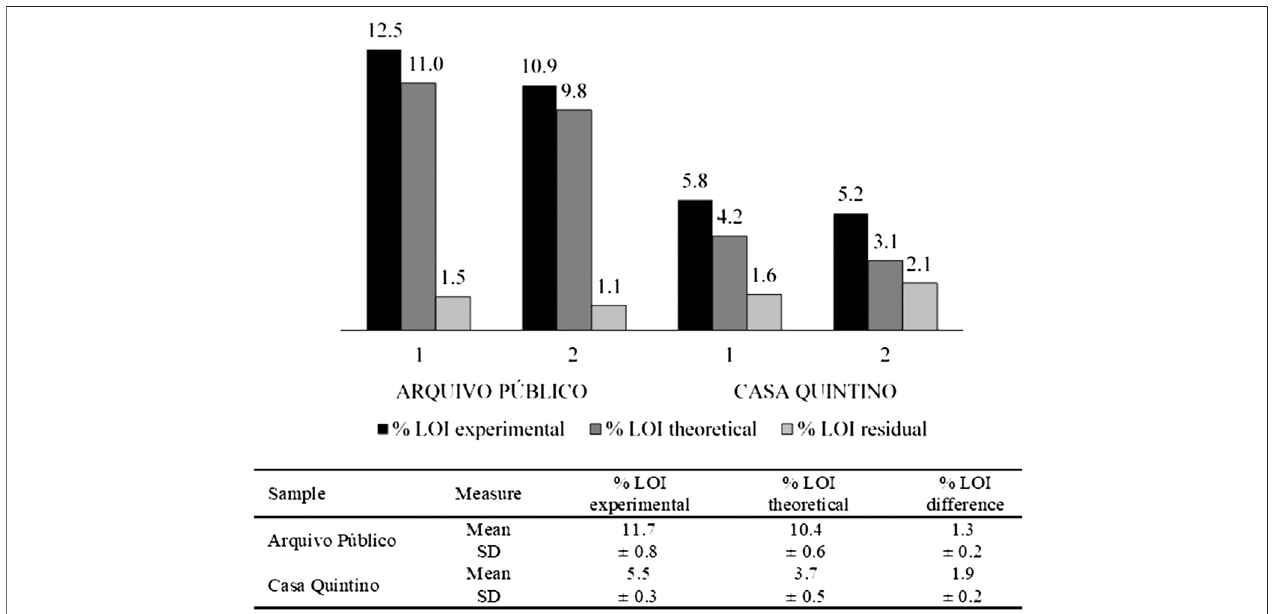
FIGURE 7 | Difference between experimental and theoretical loss on